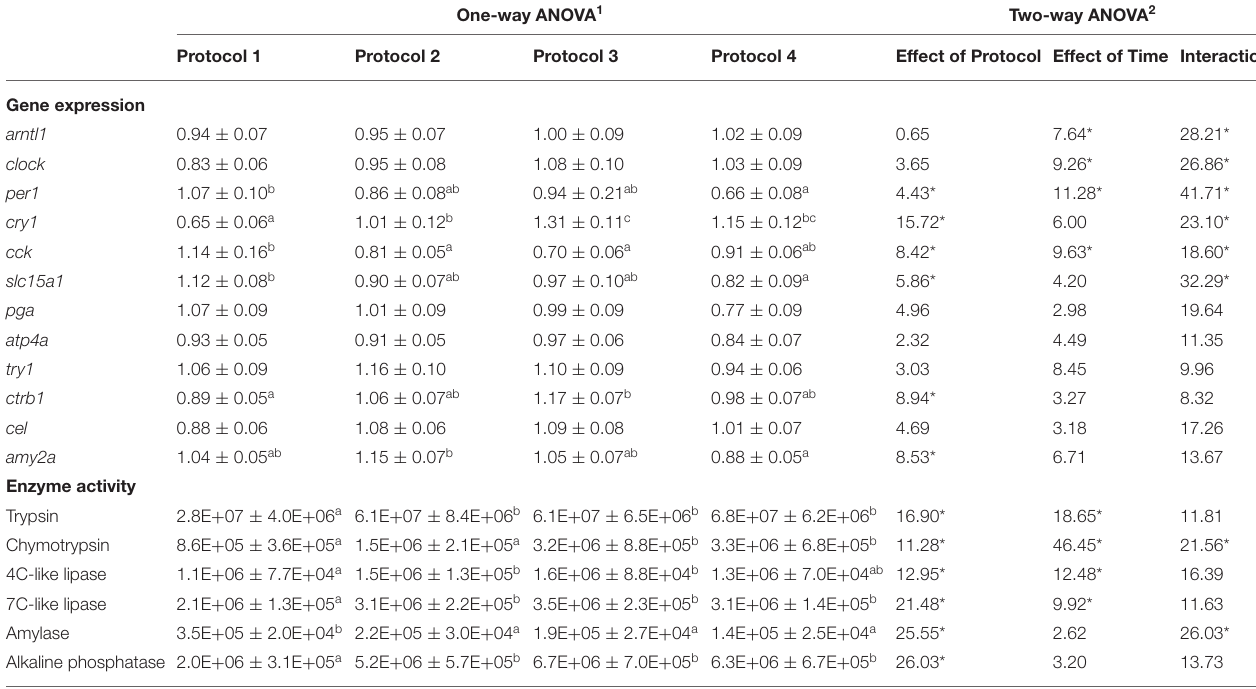
TABLE 3 | Daily average values for gene expression and enzyme activity in Senegalese sole juveniles fed different daily experimental